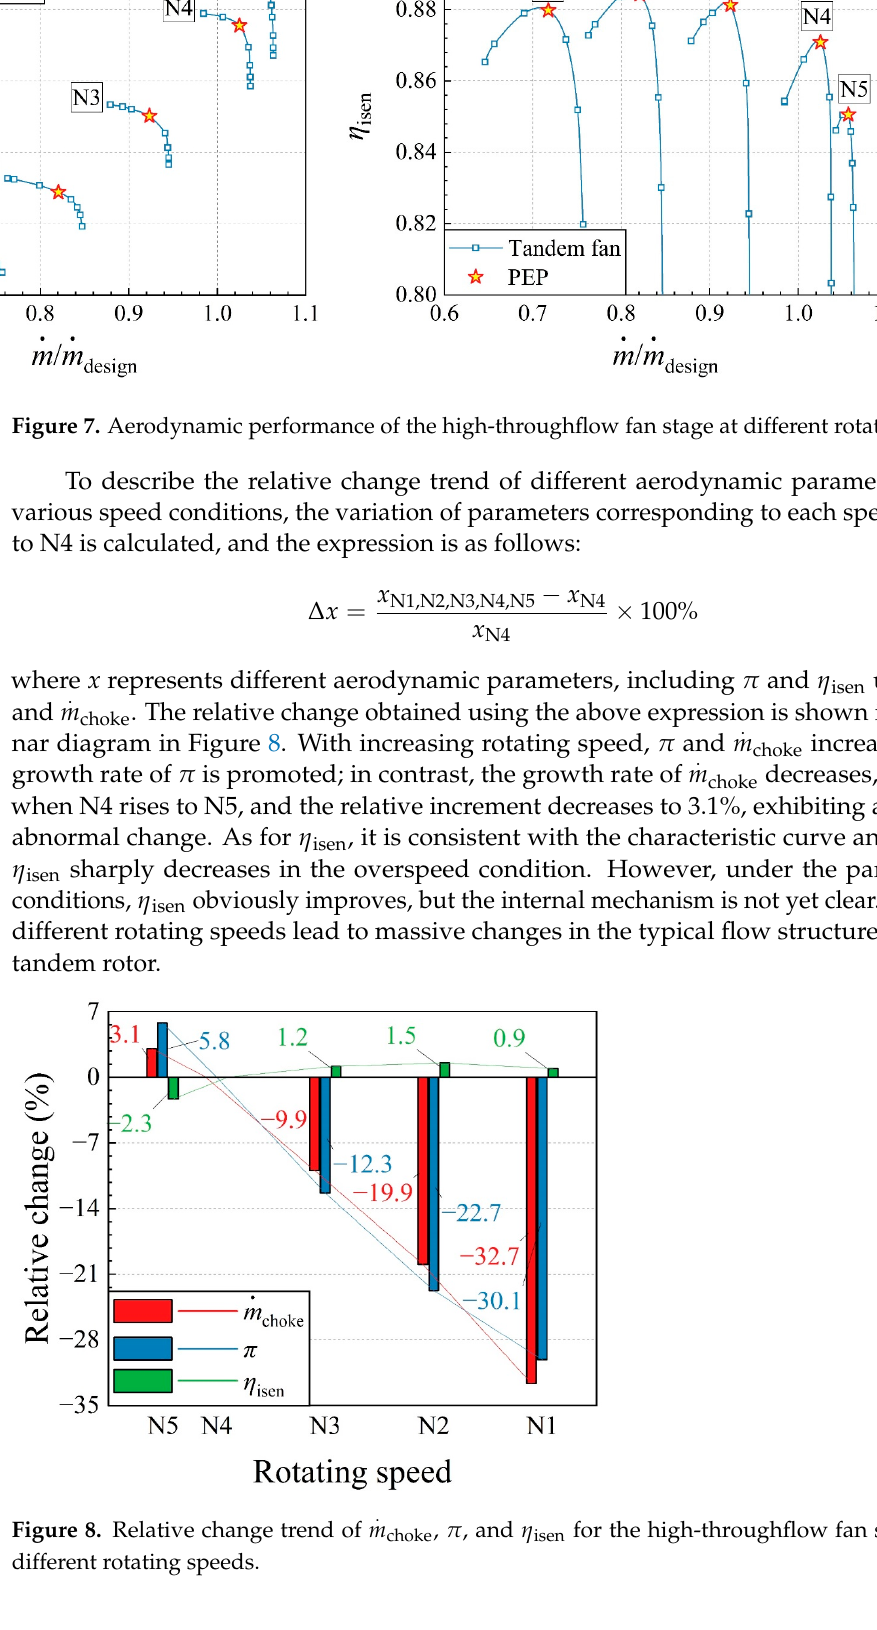
Figure 8. Relative change trend of m (cid:4662) different rotating speeds.